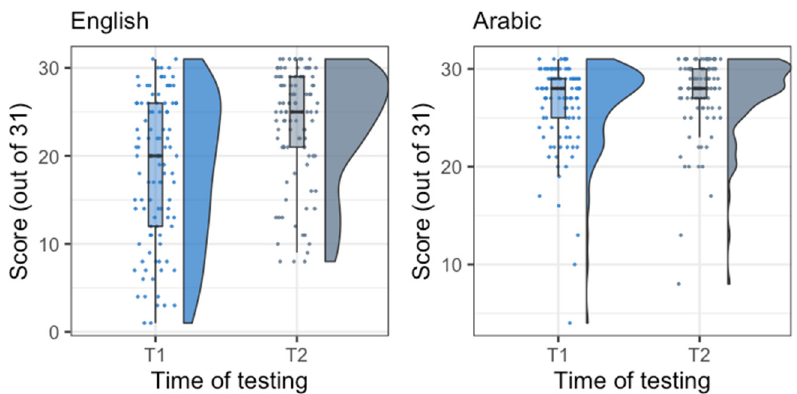
Figure 1. Participants’ morphosyntactic accuracy score at T1 and T2 in English ( left ) and Arabic ( right ). Each point is one participant, and it shows their total score out of 31 (on the y -axis). Points appear jittered horizontally due to discreteness (i.e., point overlap). The split violin, to the right of the points, is a density plot indicating the distribution of the data. Peaks in the density plot indicate where participants are concentrated.